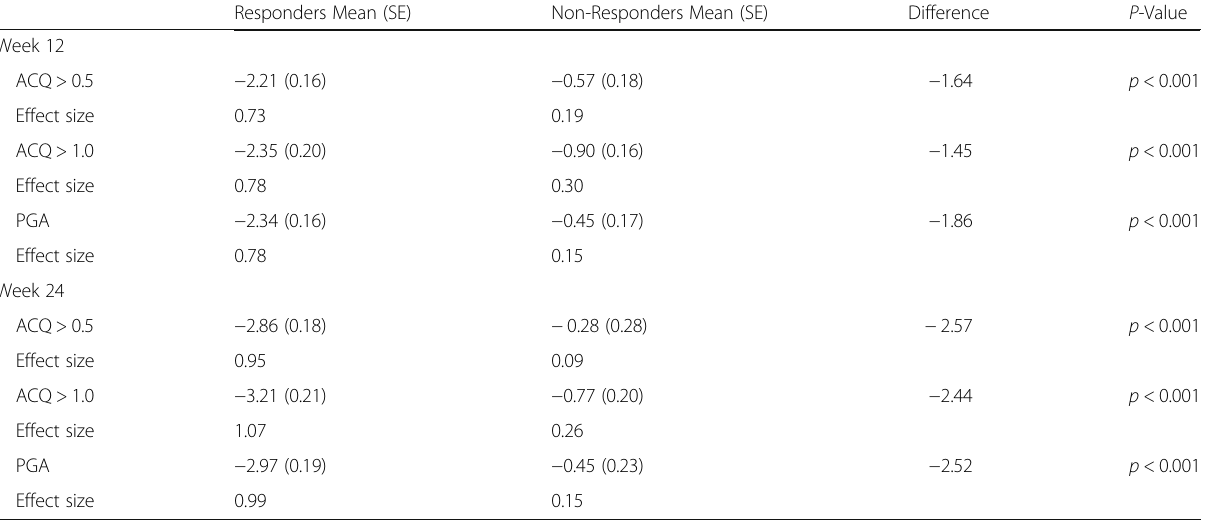
Table 2 Responsiveness of ASD Symptomatic Days in a 7-Day Period at Weeks 12 and